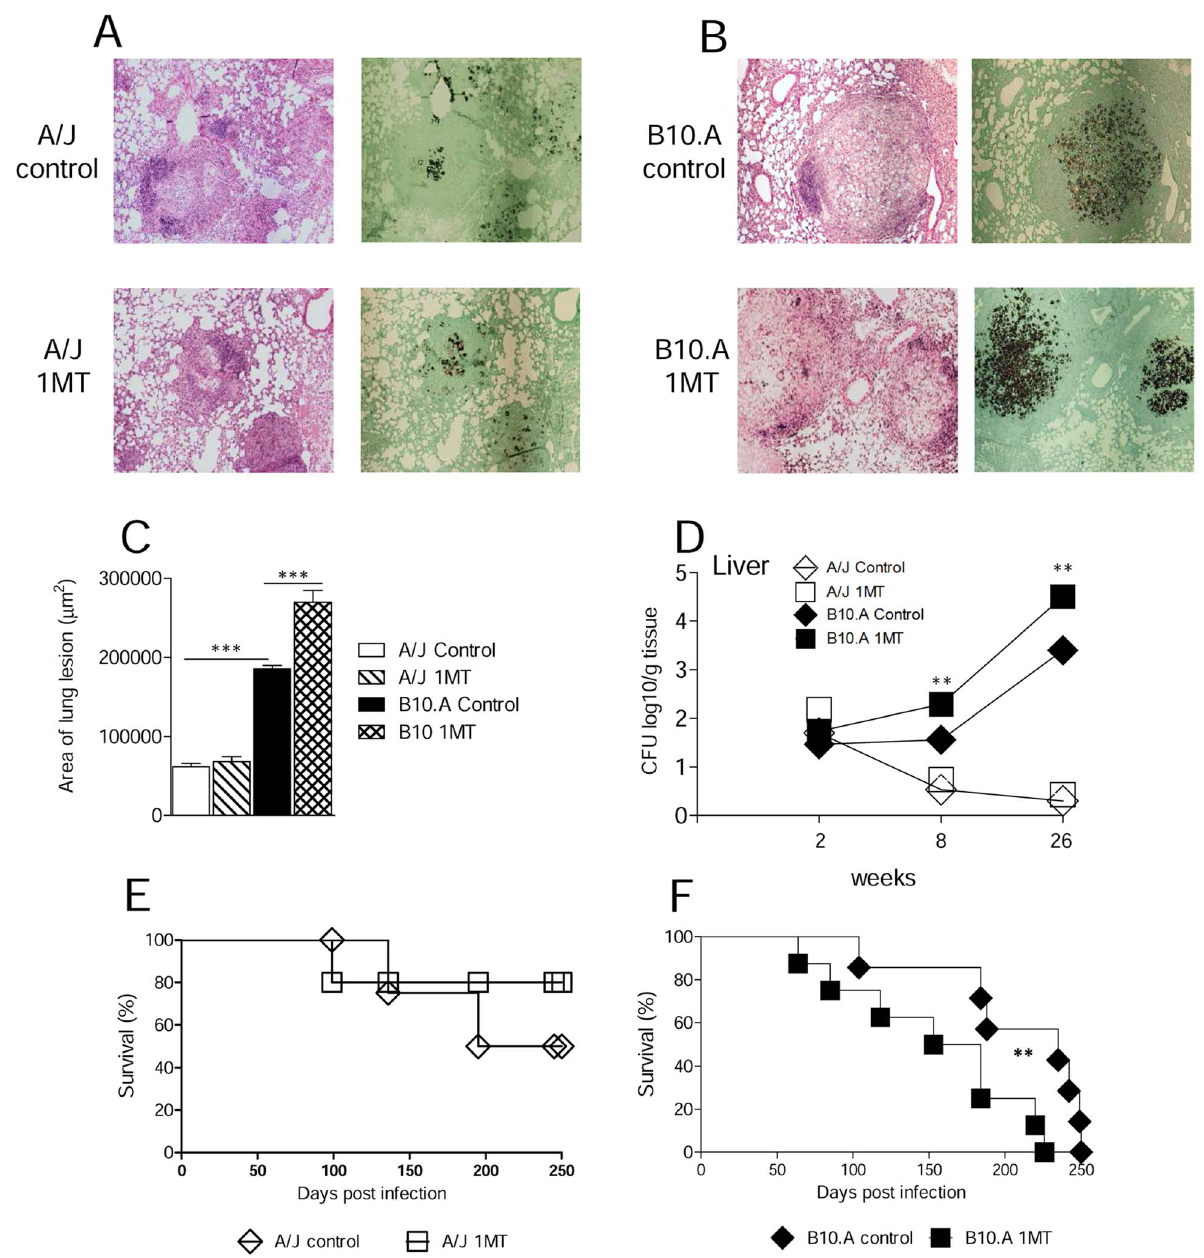
P. brasiliensis yeast cells obtained from groups of 5–6 mice. For panels: A and B , HE-stained, magnification 6 10, Grocott-stained, magnification 6 10. ( C ) Morphometric analysis of lung lesions of 1MT treated and untreated B10.A and A/J mice at week 8 post-infection (n=5–6). ( D ) At weeks 2, 8 and 26 after infection, the presence of viable yeasts was determined in the liver of 1MT treated and untreated B10.A and A/J mice (n=5–6). ( E, F ) Survival times of 1MT treated or untreated A/J and B10.A mice (9–10 mice per group) infected with 1 6 10 6 P. brasiliensis yeasts were determined for a period of 250 days. The results are representative of two independent experiments (** p , 0.01; *** p , 0.001).